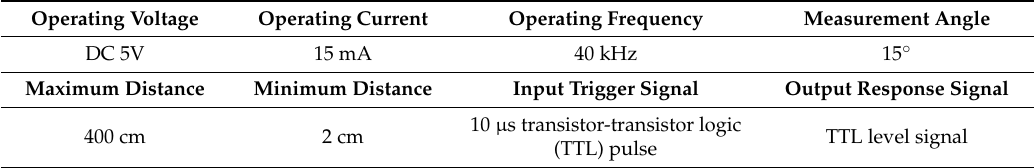
Figure 4. Ultrasound module of HC-SR04: Front ( left ) and back ( right ) faces. Table 2. The main technical parameters of HC-SR04.